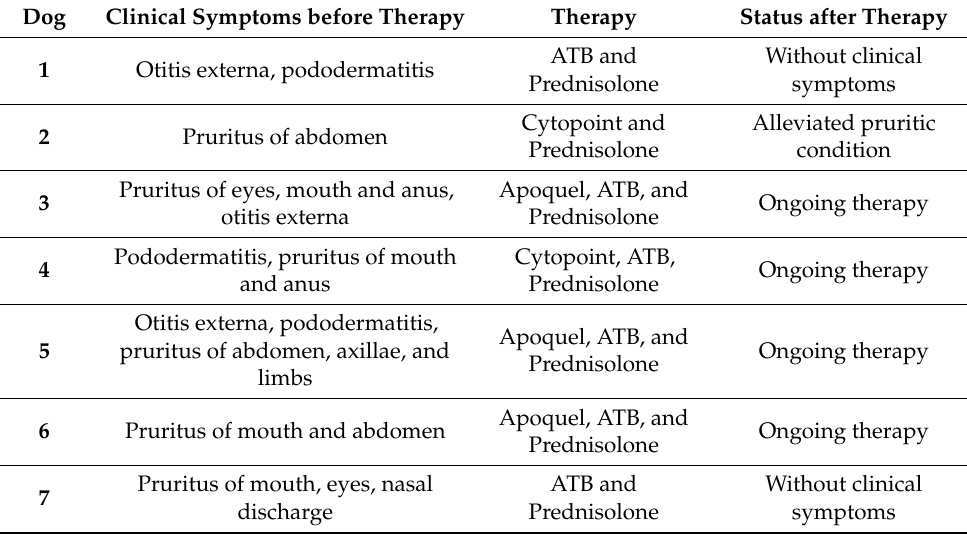
Table 5. Clinical symptoms before therapy and after treatment applied to the second group of dogs.